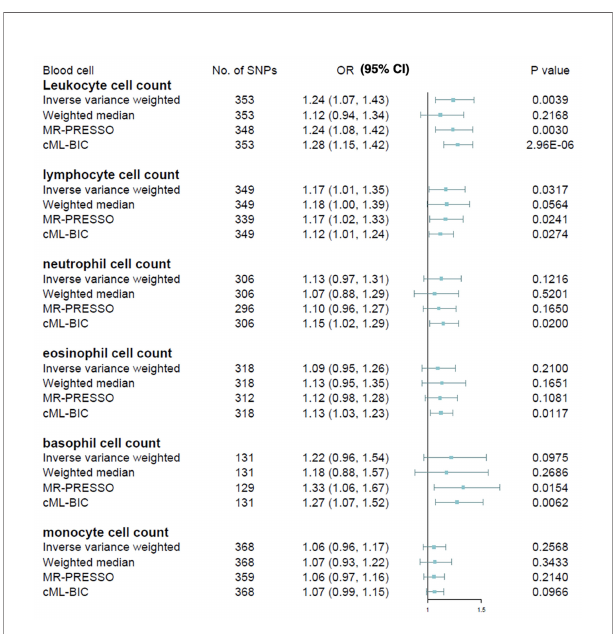
FIGURE 3 | Mendelian randomization results for the relationship between cell counts of lymphocyte subpopulation and multiple sclerosis. AC, absolute count.